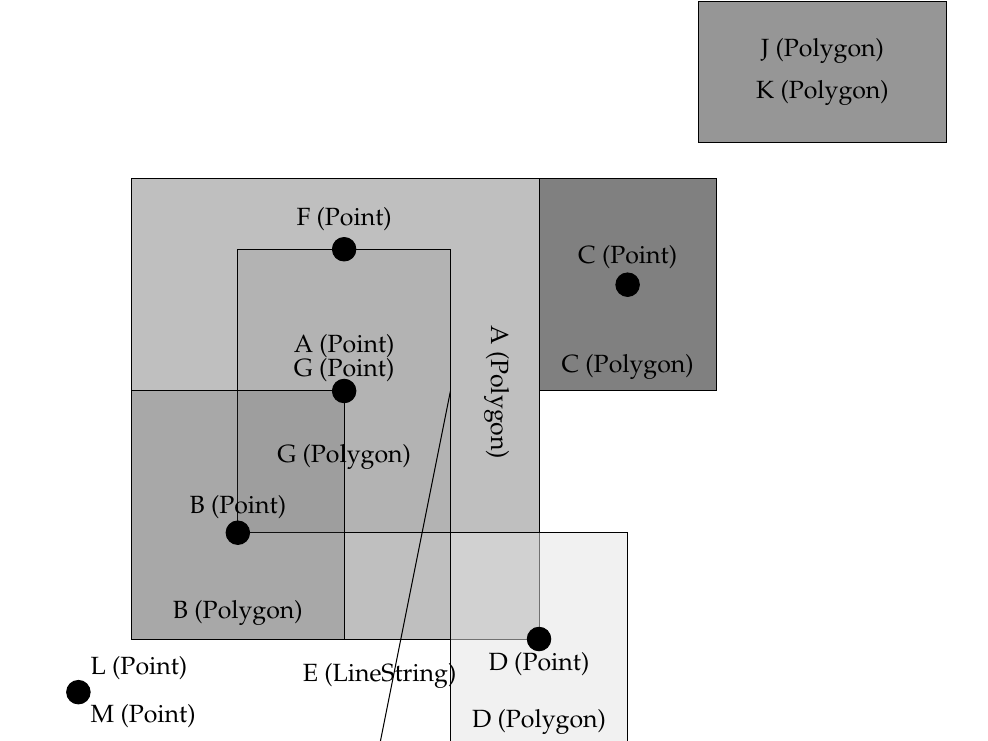
Figure 1. Abstract view of the geometries which are part of the benchmark dataset. Geometries A, B, C, D, G, J and K represent Polygon geometries and (aside from J and K) all have a center Point geometry as well. Geometry E represents a LineString geometry, while geometries F, L and M represent Point geometries. Geometries H and I are empty geometries and not visible in this figure. All geometries are represented in the CRS84 geodetic system, except for geometry M which is represented in EPSG:4326. Each geometry is represented both using WKT and GML